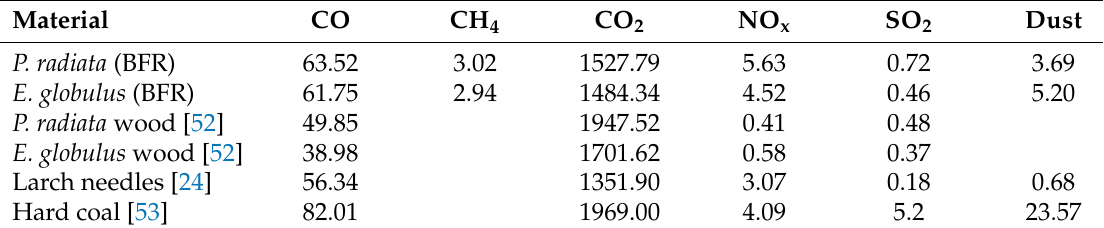
Table 7. Dust and gas emission factors ( E , kg Mg − 1